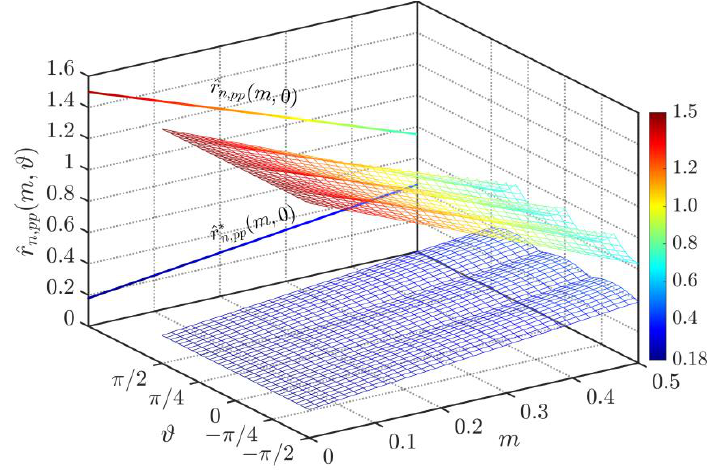
Figure 9. Normalized, peak-to-peak, neutral current ripple as a function of the modulation index m and phase angle ϑ in single (top 3D plot) and three interleaved (bottom 3D plot) carriers. On the left-hand side, a comparison of the normalized maximum peak-to-peak values in single carriers and three interleaved (“*”) carriers.